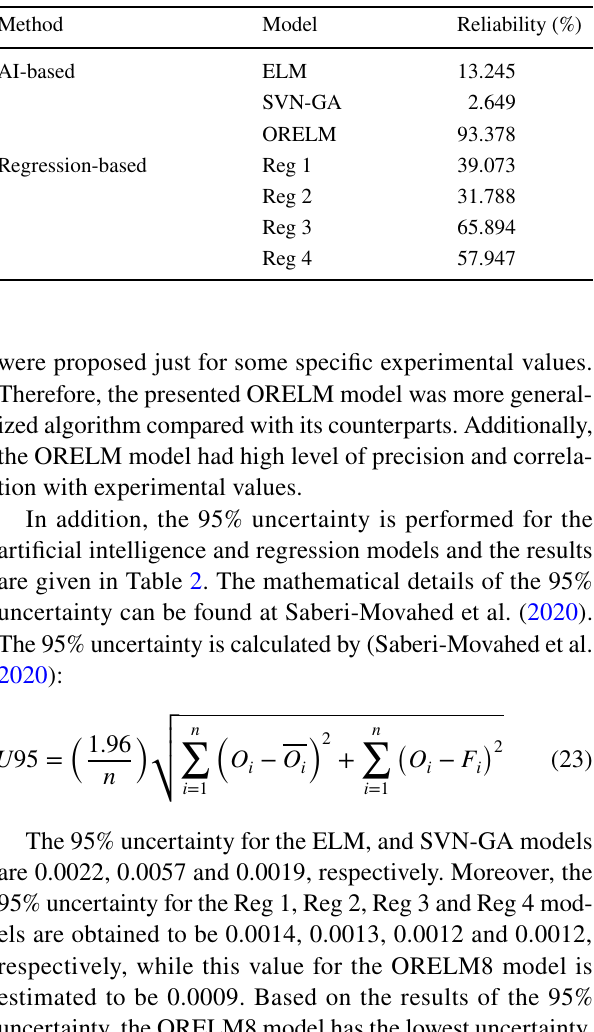
Table 3 Results of reliability analysis for different artificial intelli- gence and regression